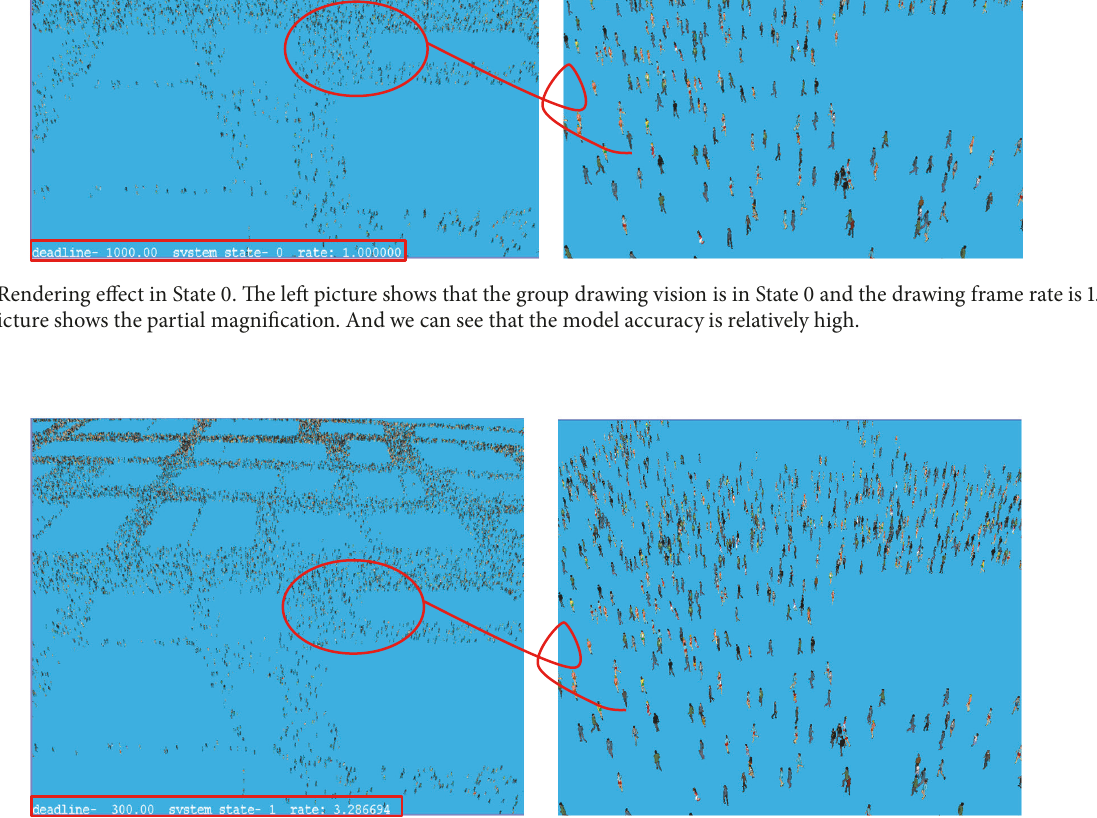
Figure 7: Rendering effect in State 1. The left picture shows that the group drawing vision is in State 1 and the drawing frame rate is 3.3 fps; the right picture shows the partial magnification. And we can see the model accuracy is remained in State 0.